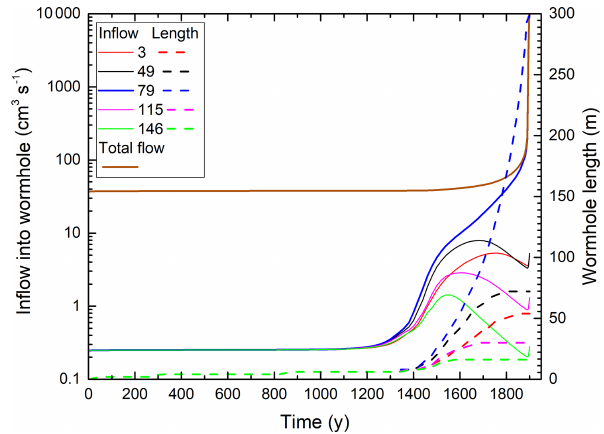
Figure 4. Temporal evolution of the total flow through the network (solid brown line), input flow rates, and lengths of wormholes at different positions (given as a y coordinate of